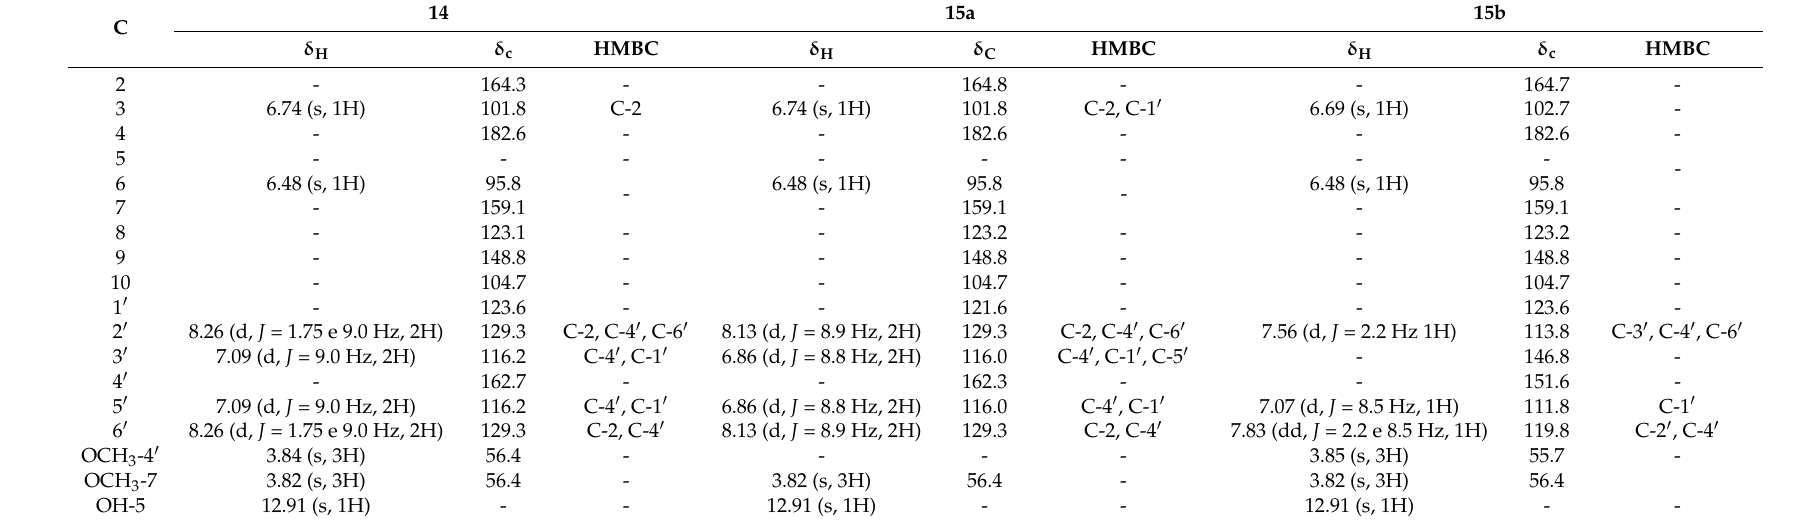
Table 1. NMR data ( 1 H, 13 C and HMBC- Heteronuclear Multiple Bond Correlation) of 14 , 15a and 15b ( δ , DMSO- d 6 , 500 and 125